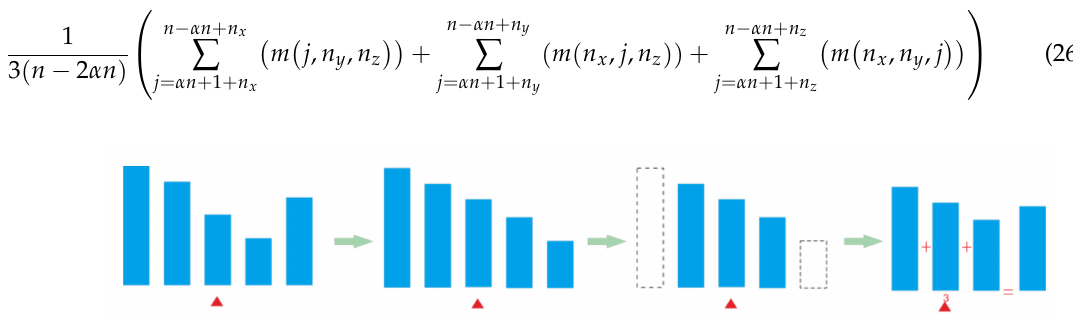
Figure 1. Schematic diagram of the α -trimmed constraint (n = 5, α =